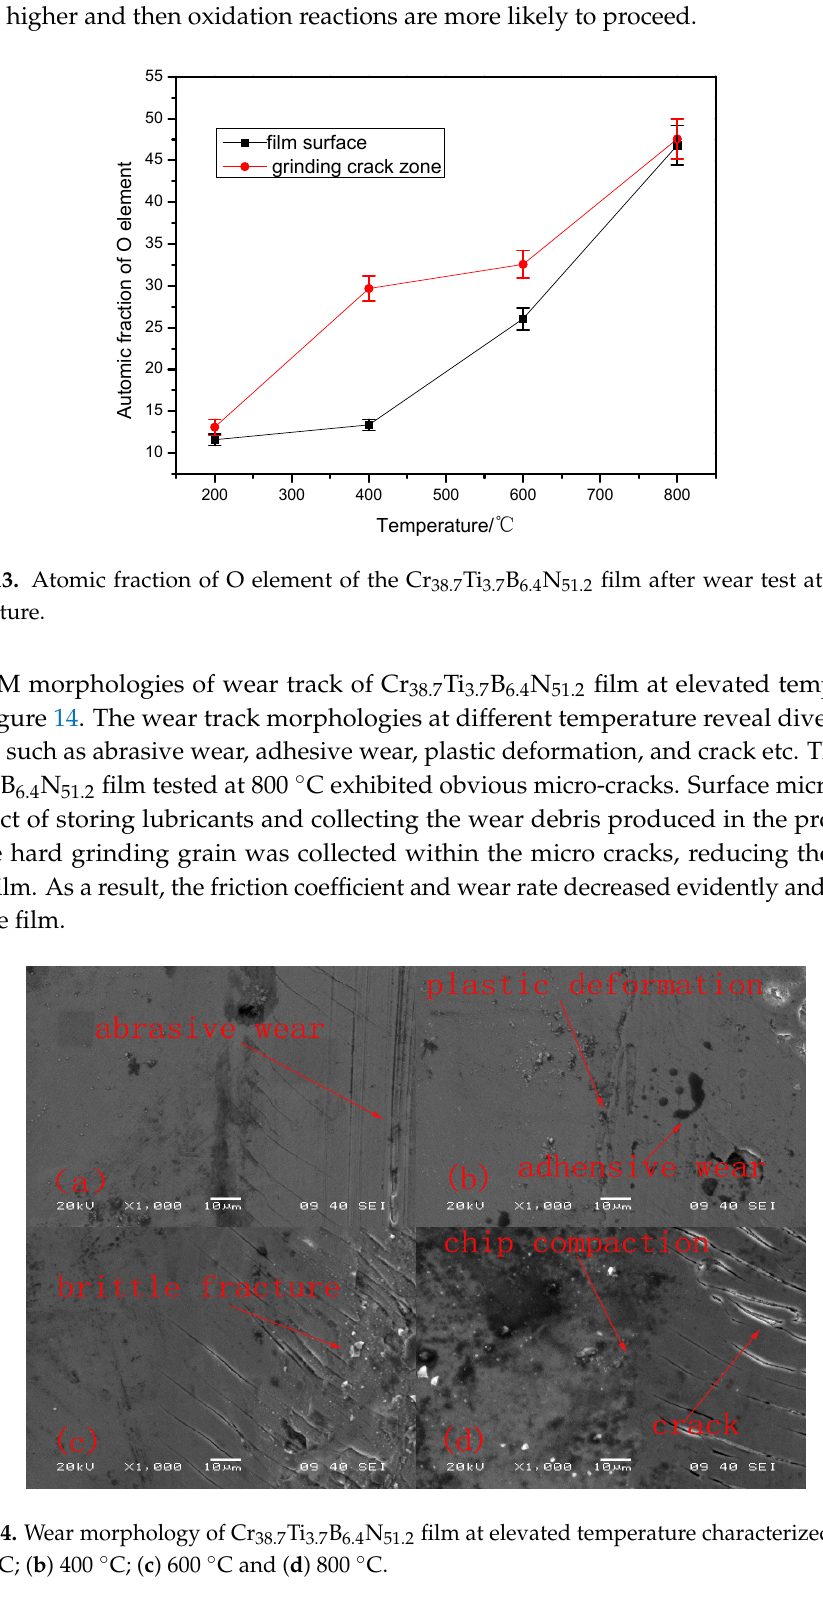
Figure 14. Wear morphology of Cr 38.7 Ti 3.7 B 6.4 N 51.2 film at elevated temperature characterized by SEM: ( a ) 200°C; ( b ) 400°C; ( c ) 600°C and ( d ) 800°C.